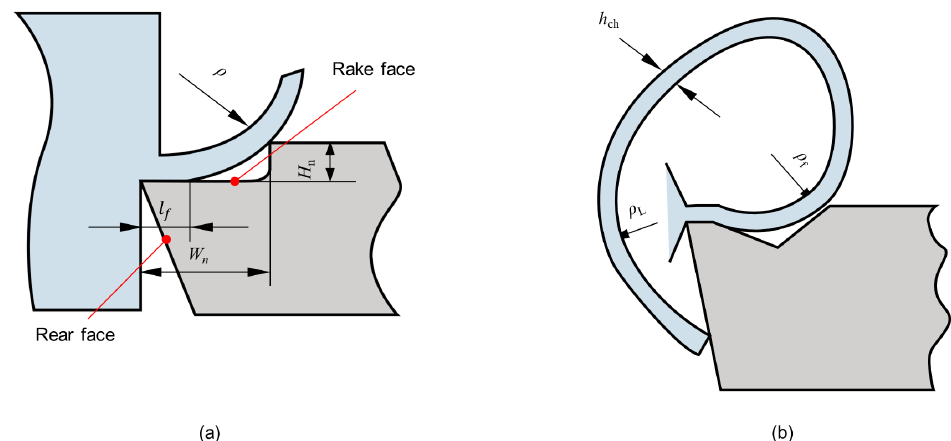
Figure 4. Chip breakage process diagram. ( a ) Chip bending process. ( b ) Chip breakage